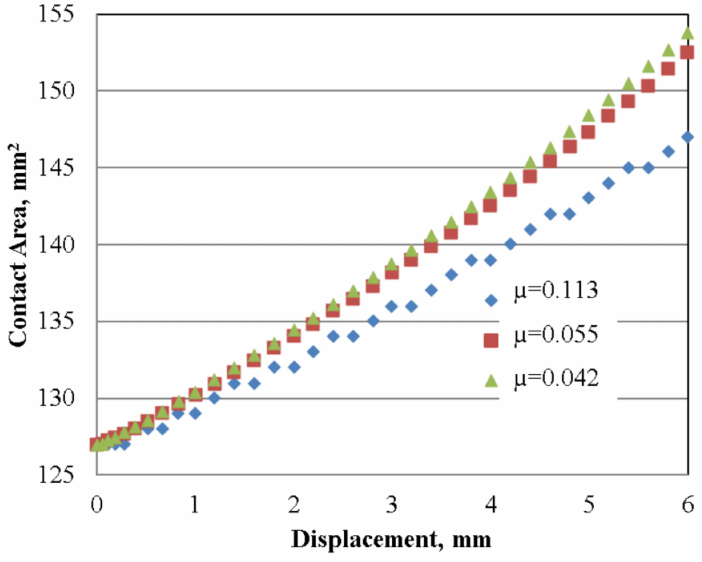
Figure 18. Influence of ram displacement on sample contact area for different friction conditions.